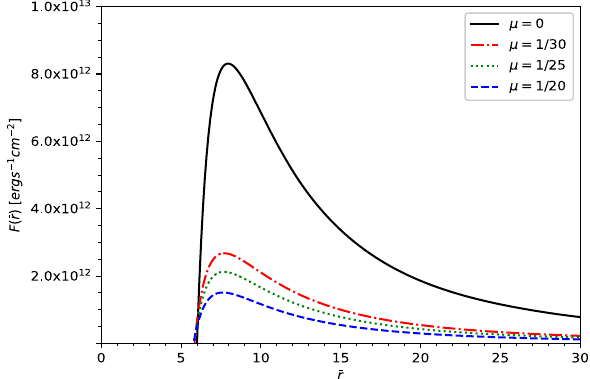
Fig. 2 The energy flux F ( ¯ r ) from a disk around a BH in EACT for different positive values of